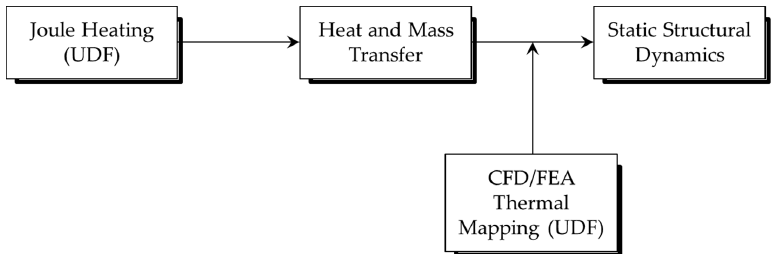
Figure 7. Schematic of a complete numerical model for electro-thermo-mechanical behavior analysis using ANSYS.